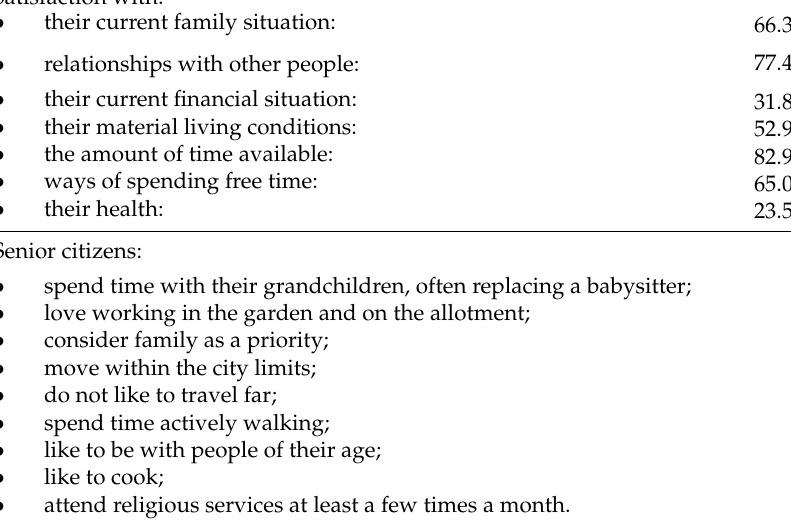
Table 6. Psychological profile of a Polish senior. Source: own elaboration on the basis of [90–101]. Data